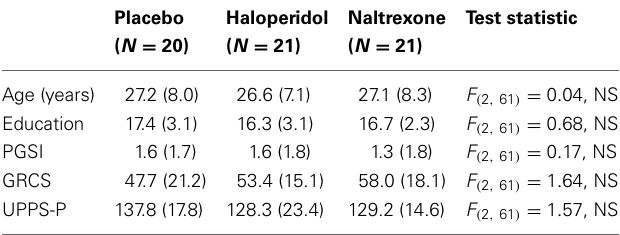
FIGURE 3 | Prolactin levels (mU/L) at T1 (baseline) and T2 (start of testing period). Naltrexone significantly increased prolactin levels. Error bars indicate standard errors of the